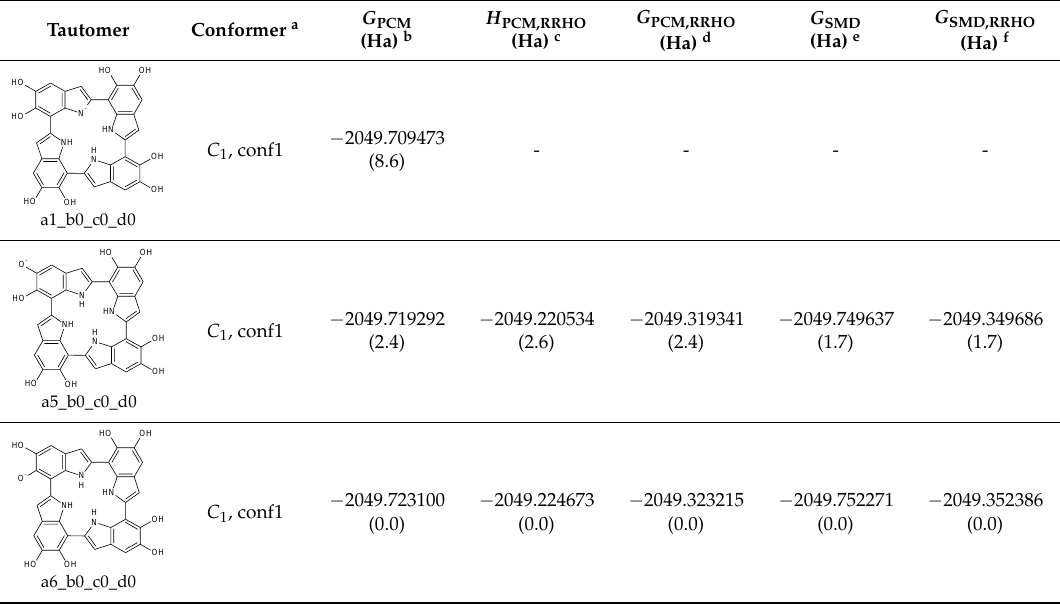
Table 3. KP-Red, monoanionic form in water.